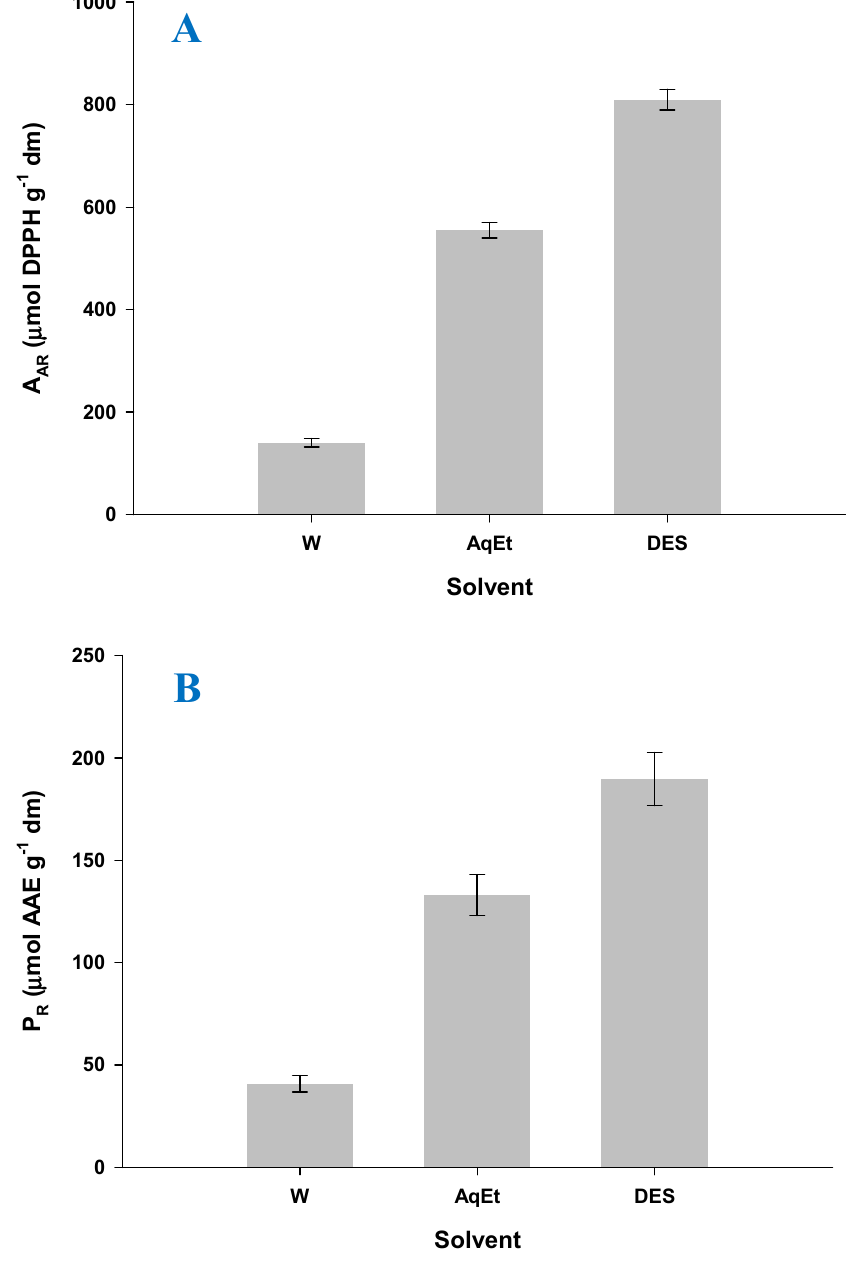
Figure 8. Plot illustrating the A AR ( A ) and P R ( B ) of the extracts produced with GL-SBz compared to 60% aqueous ethanol and water. Samples were pretreated with ultrasonication for 15 min, with a P = 104.33 W at room temperature (25 ± 2 °C). After pretreatment, batch stirred-tank extractions were performed under optimized conditions ( t = 240 min, T = 80 °C), at R L/S = 10 mL g − 1 and 500 rpm.